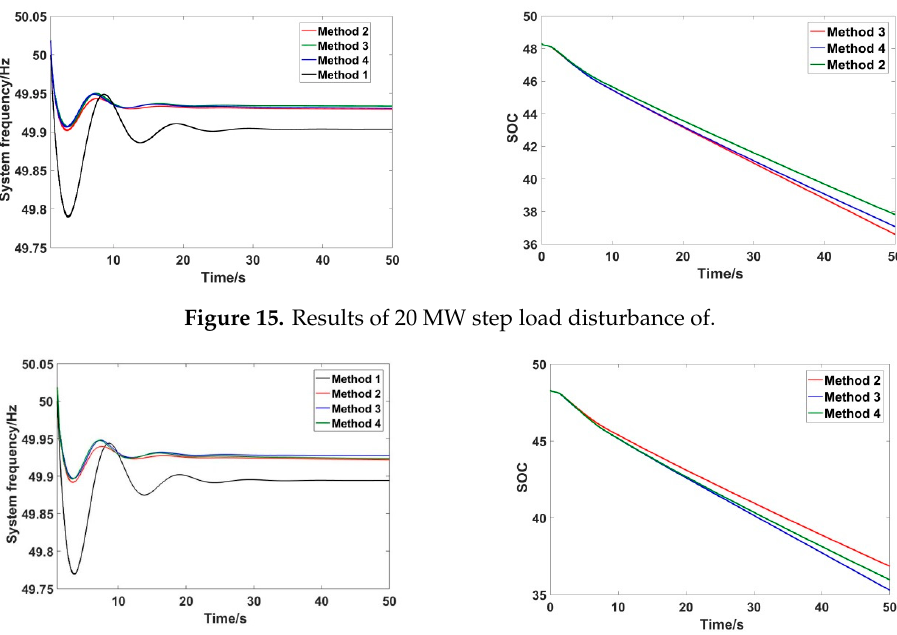
Figure 14. Results of 19 MW step load disturbance of.